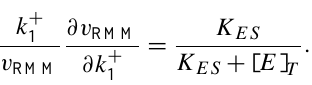
and for the RMM